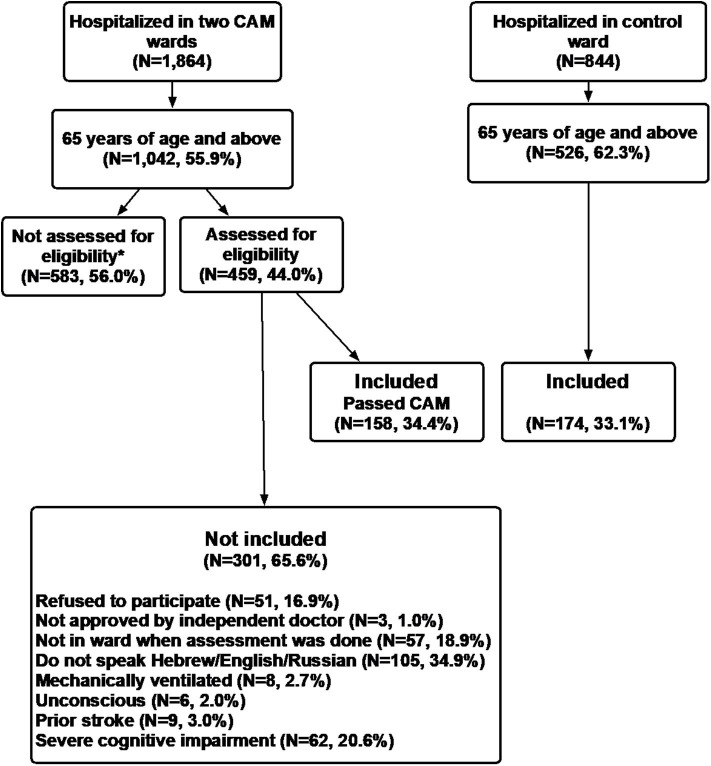
*Not assessed for eligibility: although the patients met the inclusion criteria there was no independent doctor or research doctor available on some of the days, and cessation of recruitment due to the Coronavirus outbreak–one of the two CAM wards was closed and converted to a Covid-19 ward.